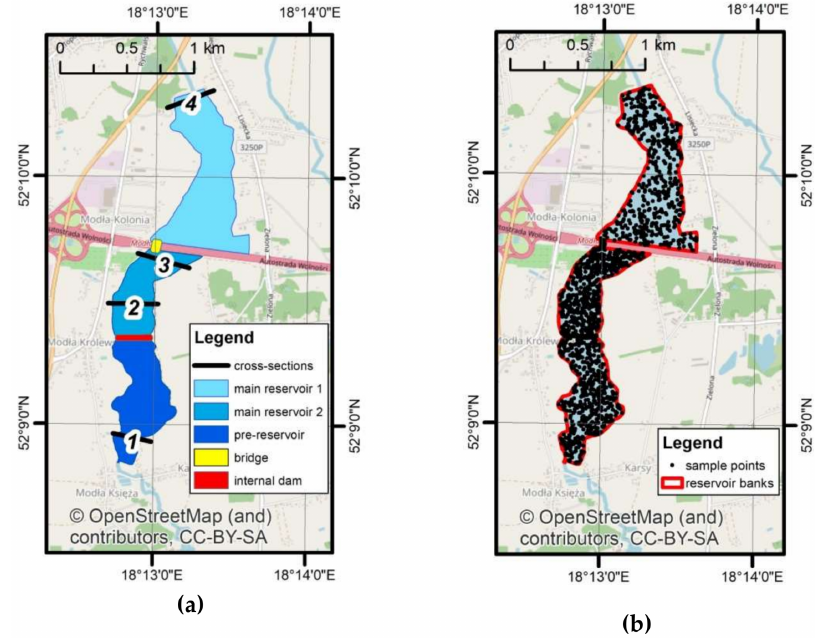
Figure 8. Elements used in the analyses: ( a ) Parts of the reservoir and location of cross-sections; ( b ) location of sample points.